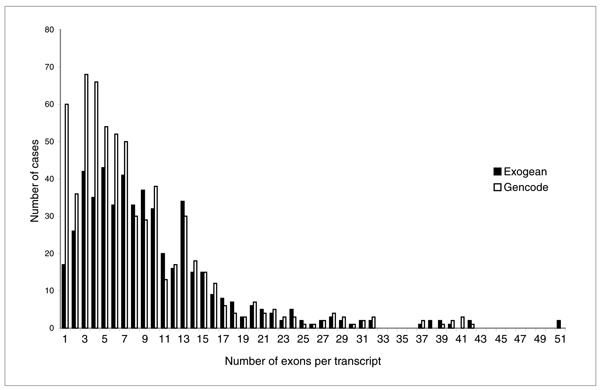
Histogram of the number of Exogean and Havana predicted transcripts as a function of their respective number of exons. For transcripts with large numbers of exons (more than 9), Exogean and Havana predict remarkably similar numbers of transcripts.